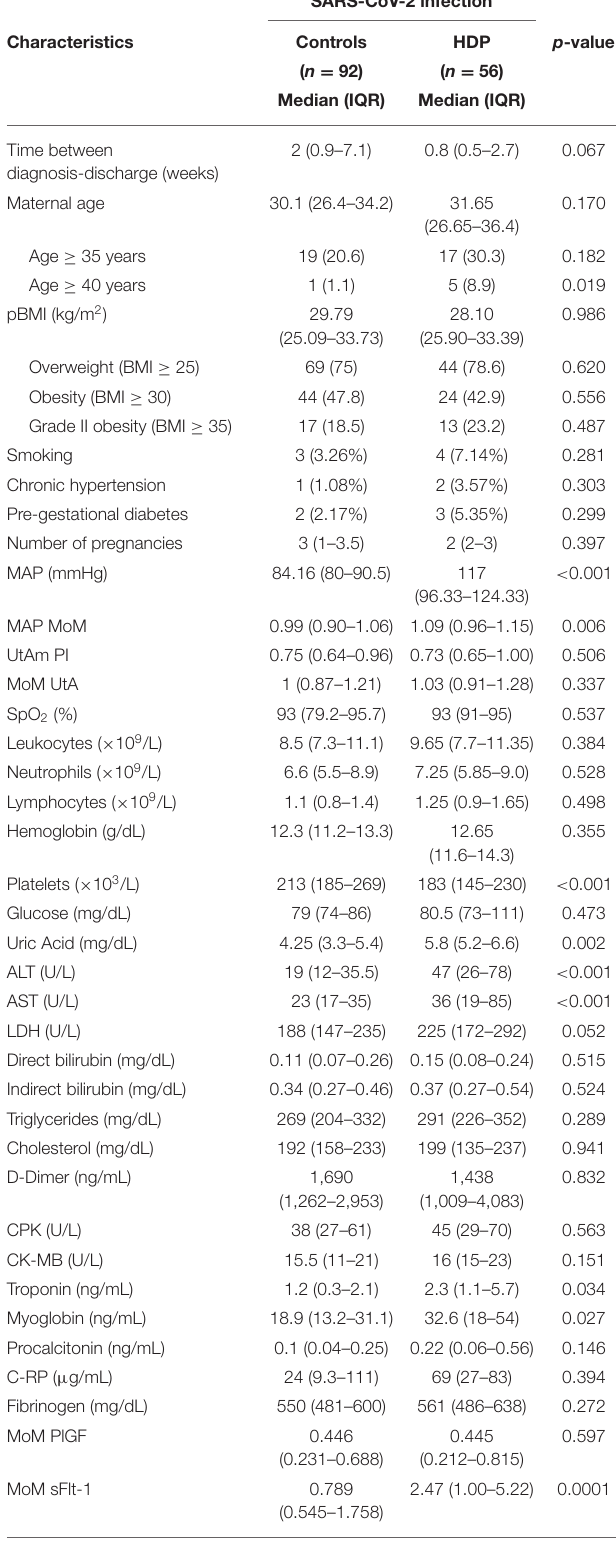
TABLE 1 | Characteristics of the included